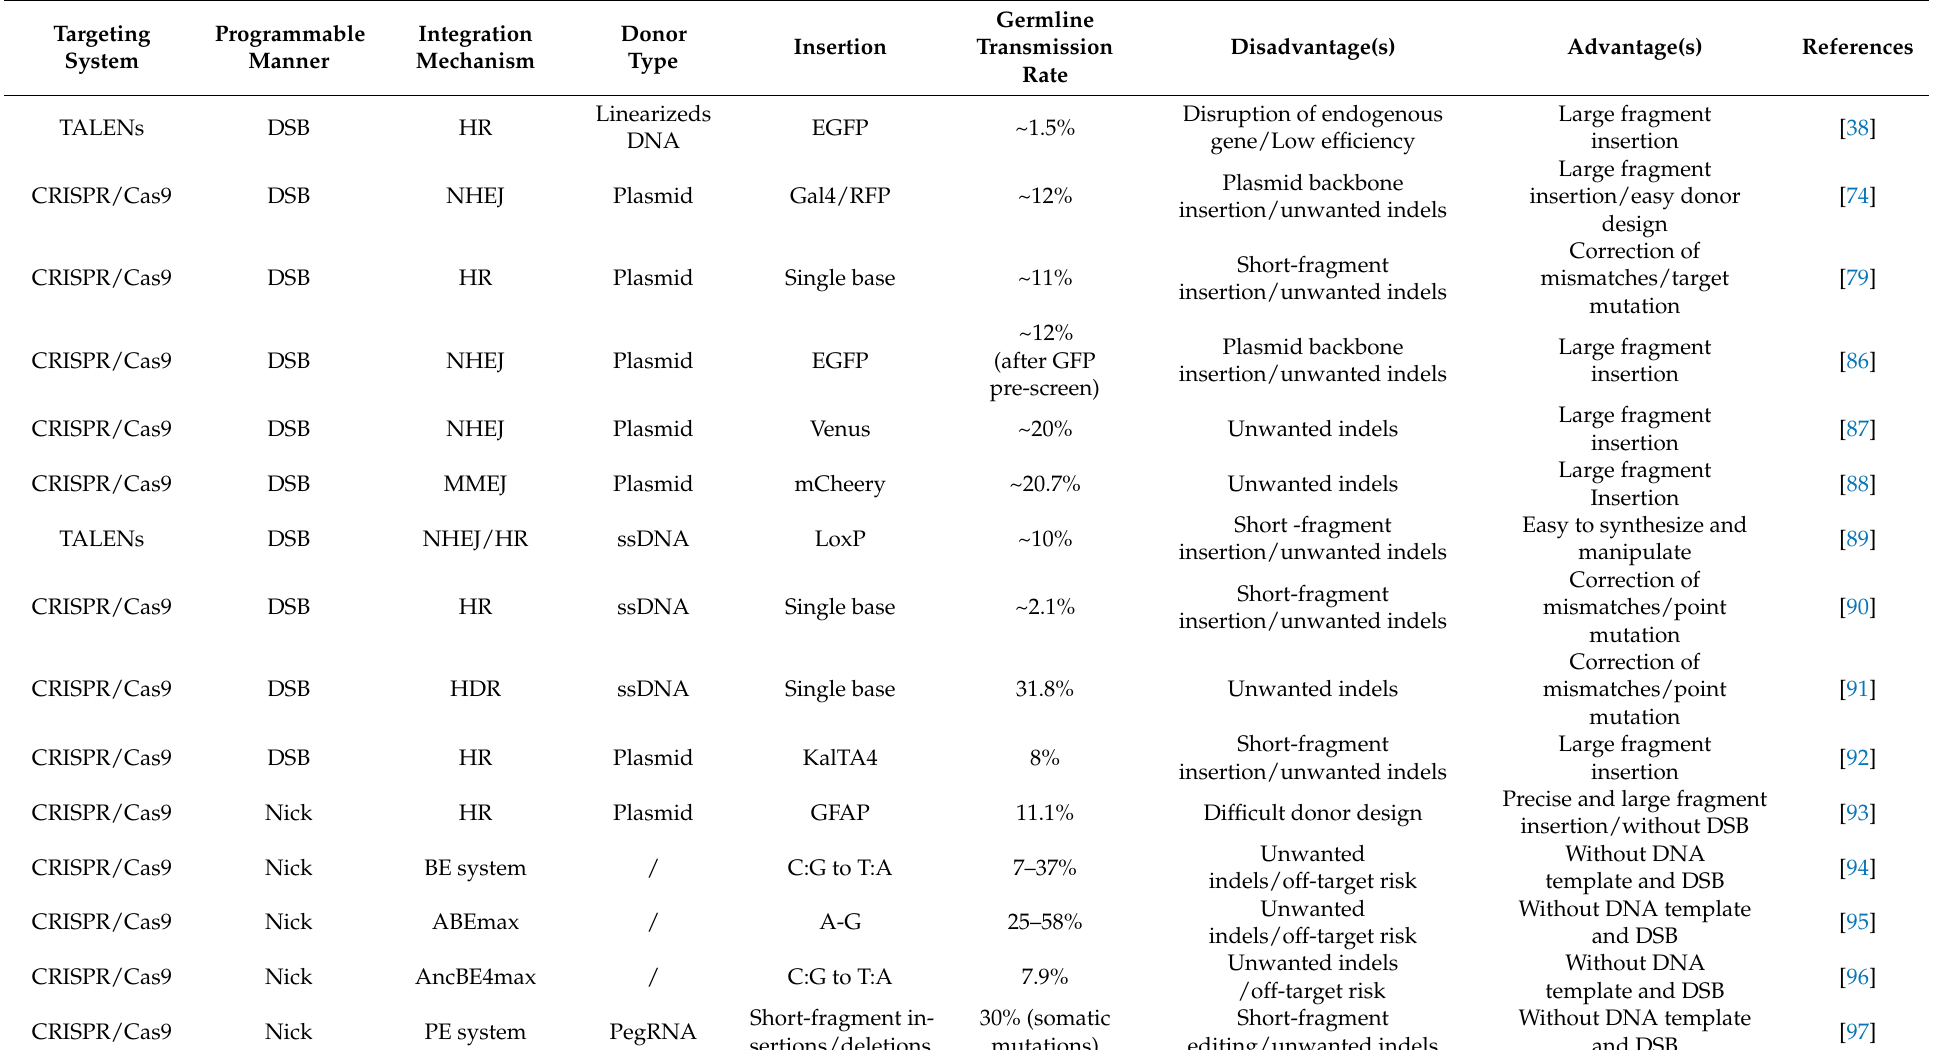
Table 2. Summary of gene fixed point-oriented reconstruction studies in